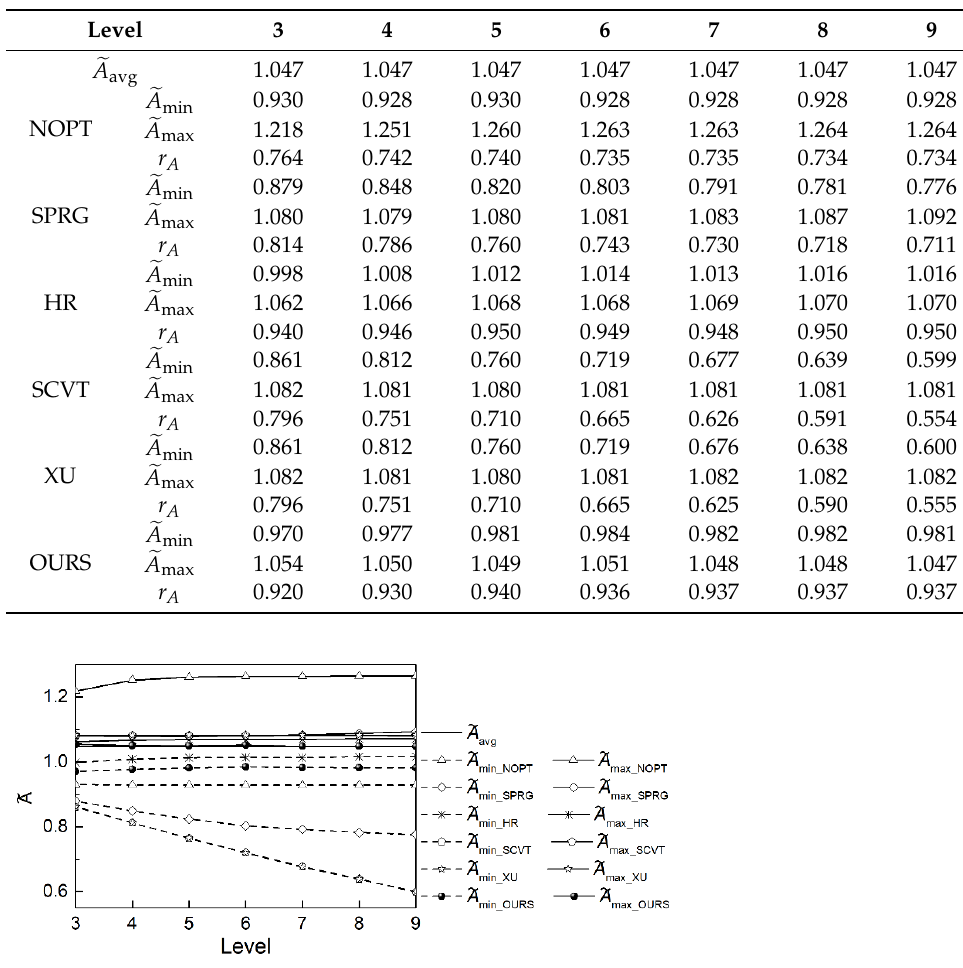
Table 2. The normalized area and the ratios between the A min and A max .